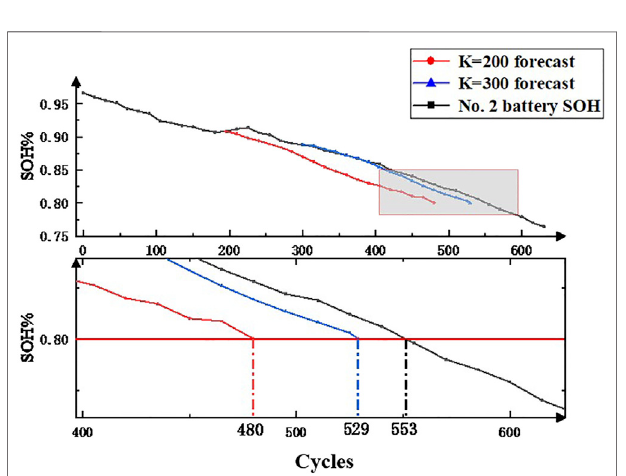
FIGURE 3 | Prediction results of the particle fi lter algorithm for No. 2 battery.